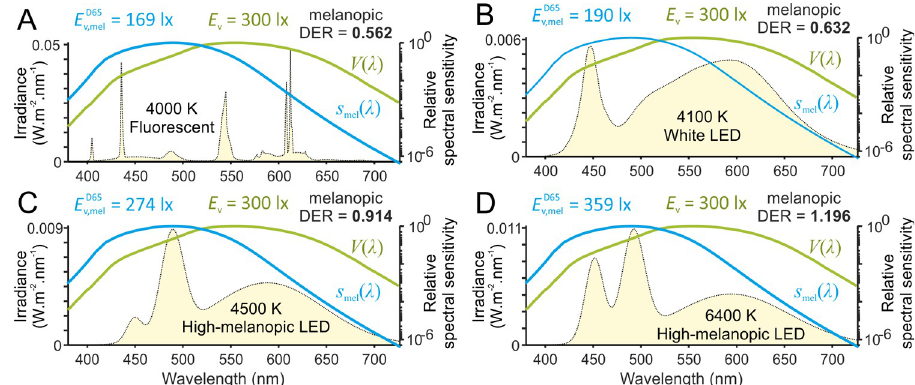
Fig 3. Impact of divergent spectral composition of electrical white light sources on melanopic efficiency. Panels A and B illustrate spectral power distributions (yellow) for commonly encountered fluorescent (A) and LED-based (B) white light sources. Panels C and D represent high melanopic content LED source of similar ( C ) and cooler (higher) correlated colour temperature ( D ) achievable with current technologies. Spectra in A and B represent CIE standard illuminants F11 and LED-B1, plotted from tabulated source data [142], spectra in C and D were modelled by combining weighted combinations of spectra from commercially available broad and narrowband LED sources. Melanopic (blue; V ( λ )) and photopic (green; V ( λ )) spectral efficiency functions are shown for reference. Photopic illuminance ( E v ) and melanopic equivalent daylight (D65) illuminance ( E D 65 ) for each spectrum is provided v ; mel